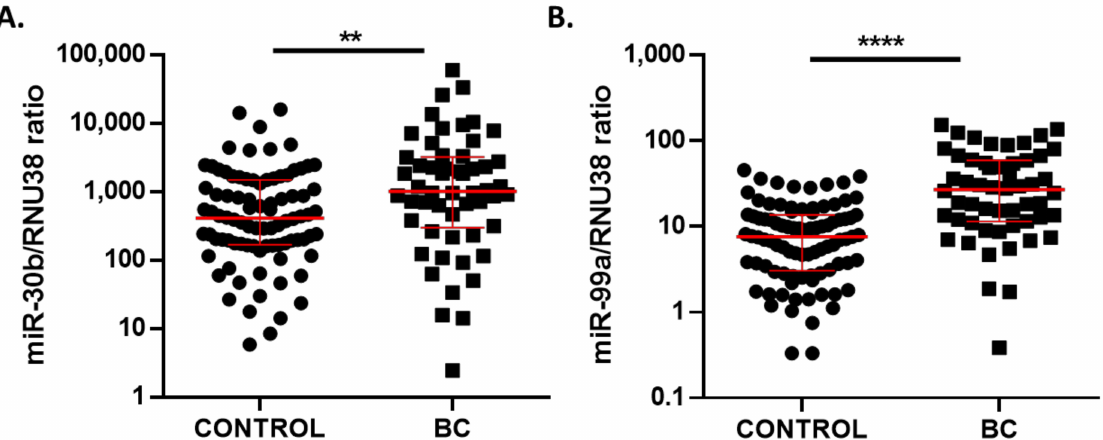
Figure 2. miR-30b-5p ( A ) and miR-99a-5p ( B ) expression levels in plasma samples of 54 BC patients and 89 healthy controls from discovery cohort. Red lines represent median ± interquartile range. ** p < 0.01; **** p <